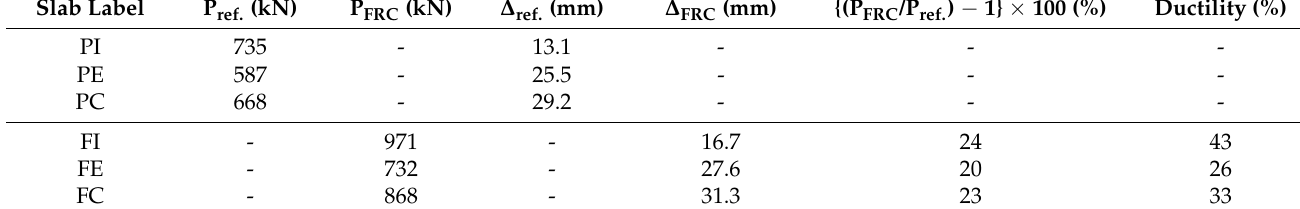
Table 7. Experimental results for tested slabs.